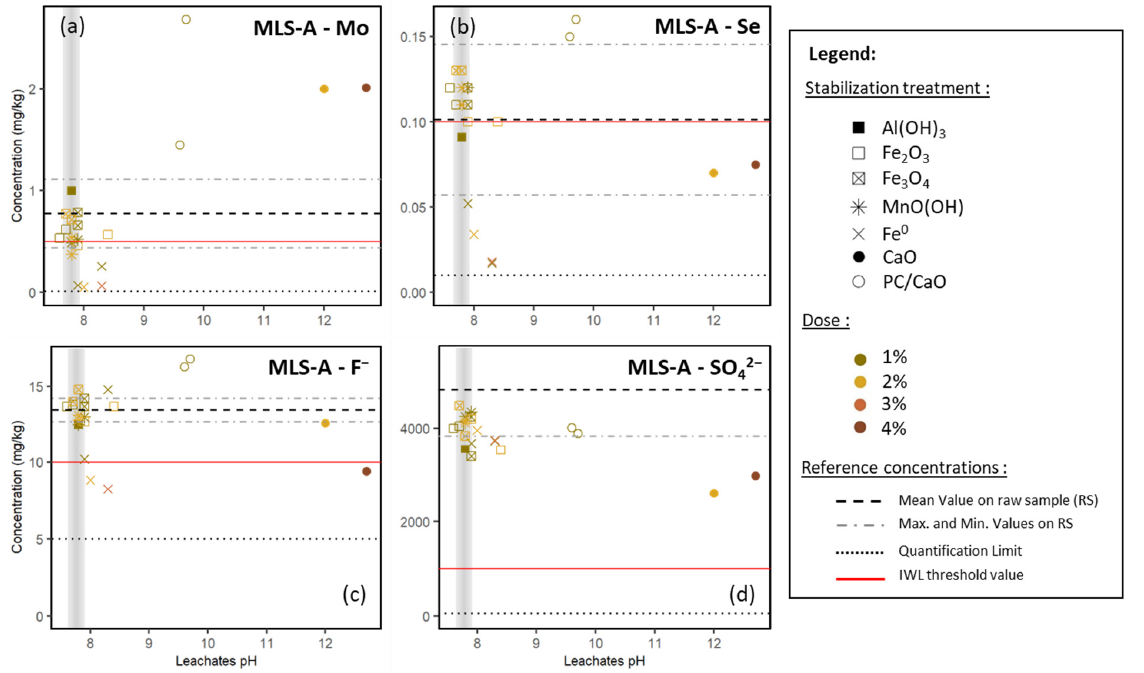
Figure 3. Mo ( a ), Se ( b ), fluorides ( c ) and sulfates ( d ) concentrations in the leachates of standardized leaching tests as a function of pH and of the stabilizing treatment in MLS-A. Vertical gray areas represent the samples commonly observed natural pH.